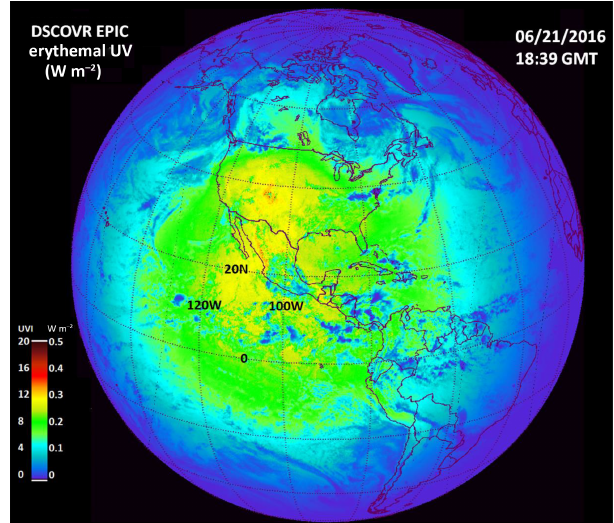
Figure 20. Erythemal irradiances centered over the United States on 21 June 2016 showing high values over the Rocky Mountains and a portions of the Sierra Nevada. The UV index reaches about 15. Local solar noon is at 99.75 ◦ W and overhead near 23.3 ◦